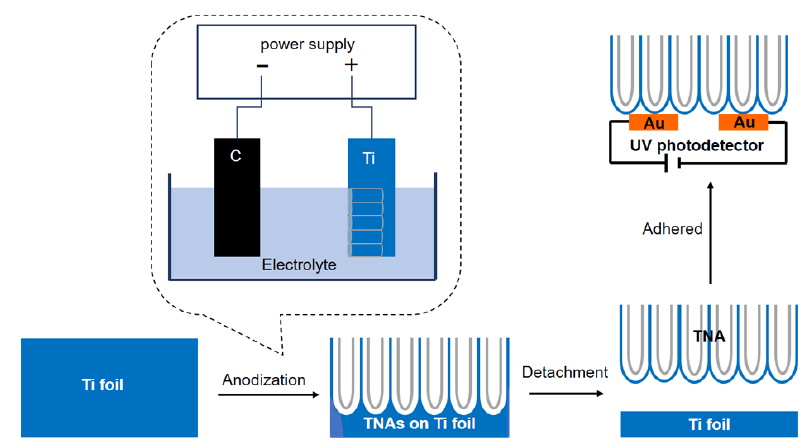
Figure 1. Preparation process of TiO 2 nanotube array (TNA)-based ultraviolet (UV) photodetectors (PDs).